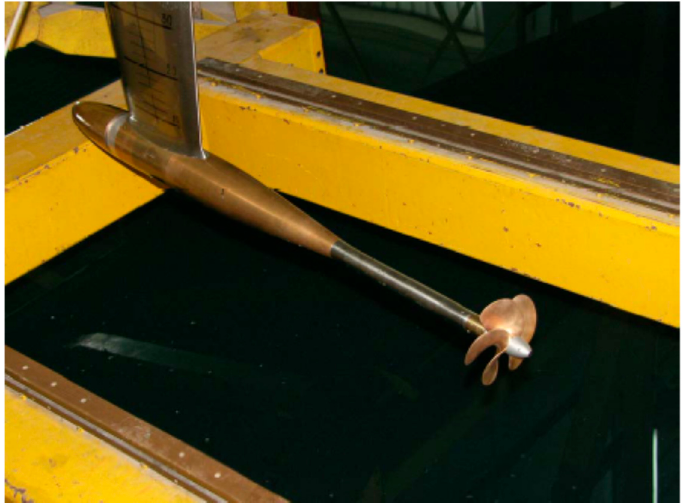
Figure 10. CTO Towing tank open water test set-up.